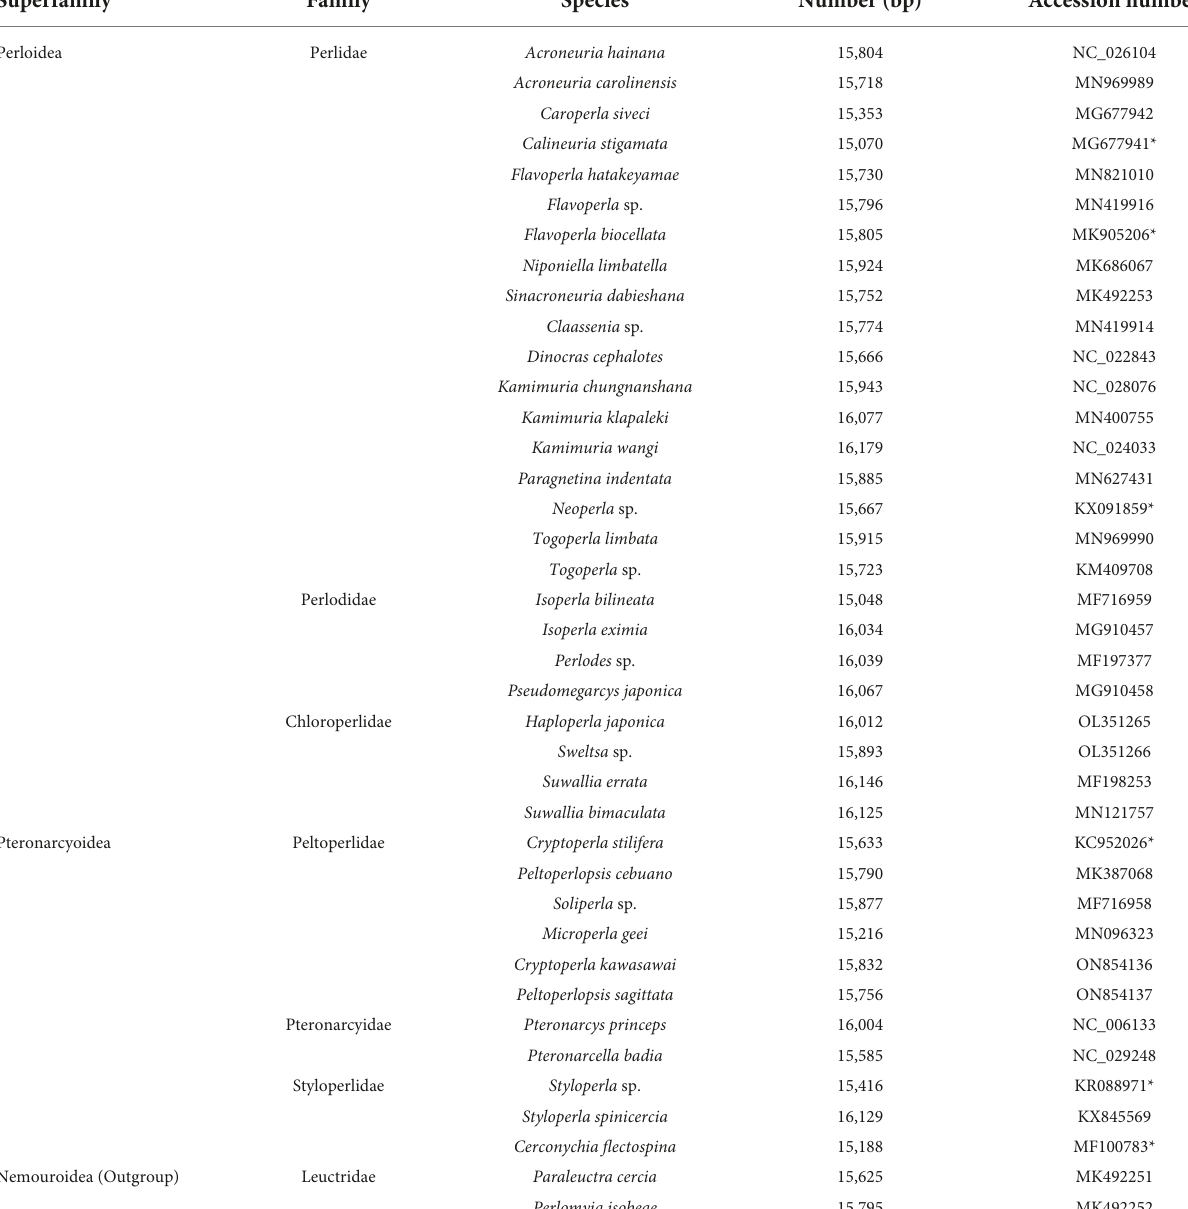
TABLE 1 List of taxa used in this